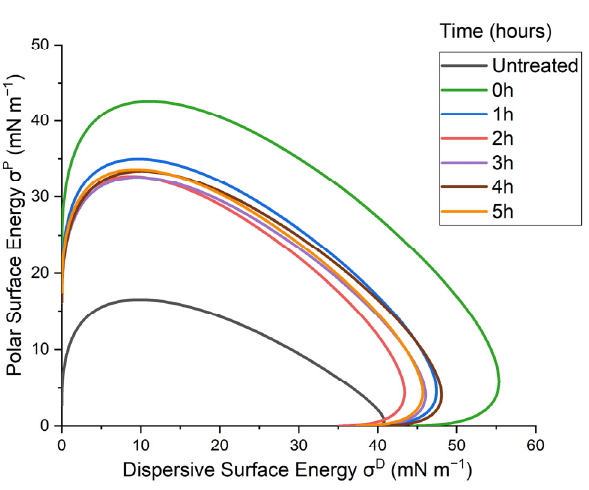
Figure 14. Wetting envelopes of untreated GFPA6 surface and µ Plasma treated as a function of time (0–5 h after the treatment).